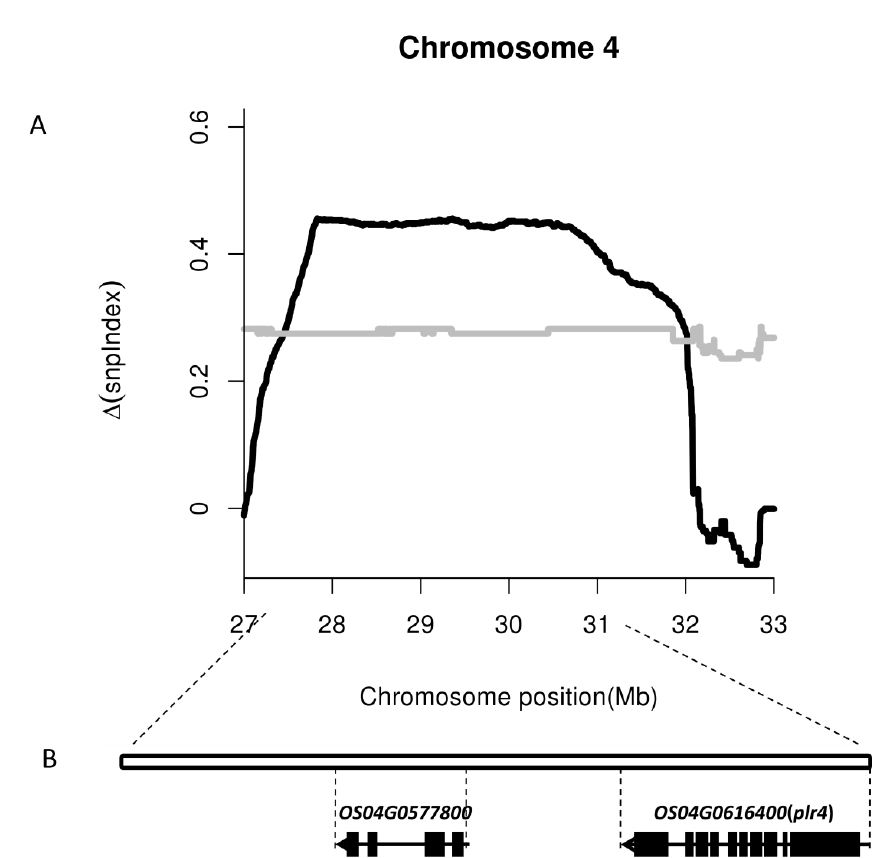
Figure 4. Identification and validation of the plr4 gene on chromosome 4. ( A ) Distribution of △ (SNP-index) on chromosome 4; and ( B ) location of plr4 via whole-genome sequencing and RNA-Seq. Table 1. The 19 differentially expressed genes demonstrated annotation functions related to the anthocyanin pathway.